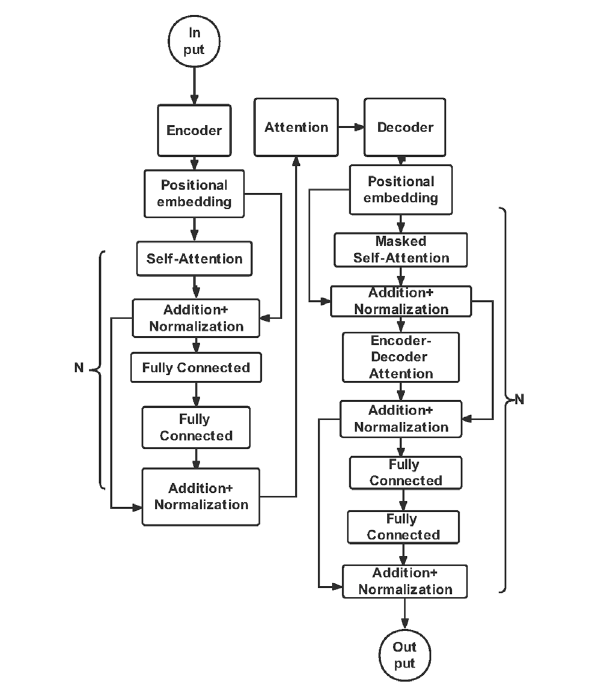
FIGURE 9 | Transformer model structure diagram. Transformer models have Input, Output, Attention mechanisms and Encoder-Decoder architecture. In our T-SIRGAN prediction module, the encoder models the relationships among orders in the sequence, and the decoder learns the variable representation